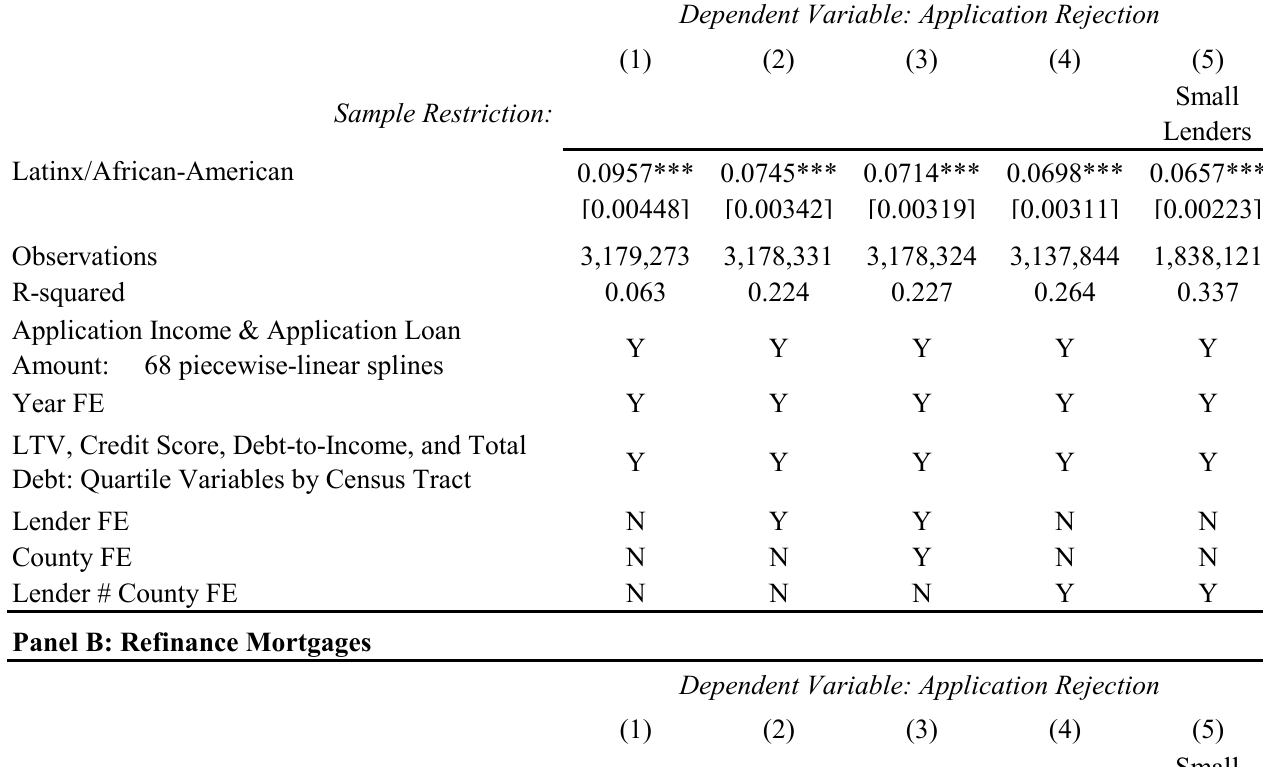
Panel A: Purchase